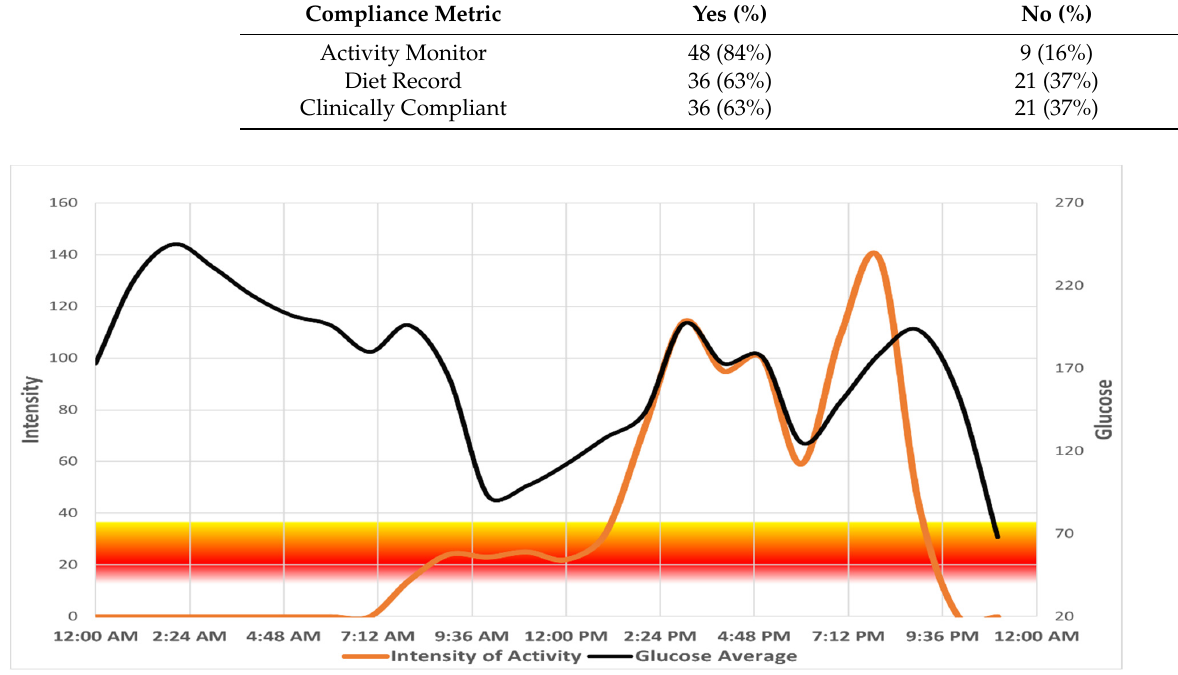
Figure 1. Graph of single day hourly averages of activity monitor and CGM measures. Intensity of activity values indicated on left side of y -axis and glucose measures obtained from CGM on right.